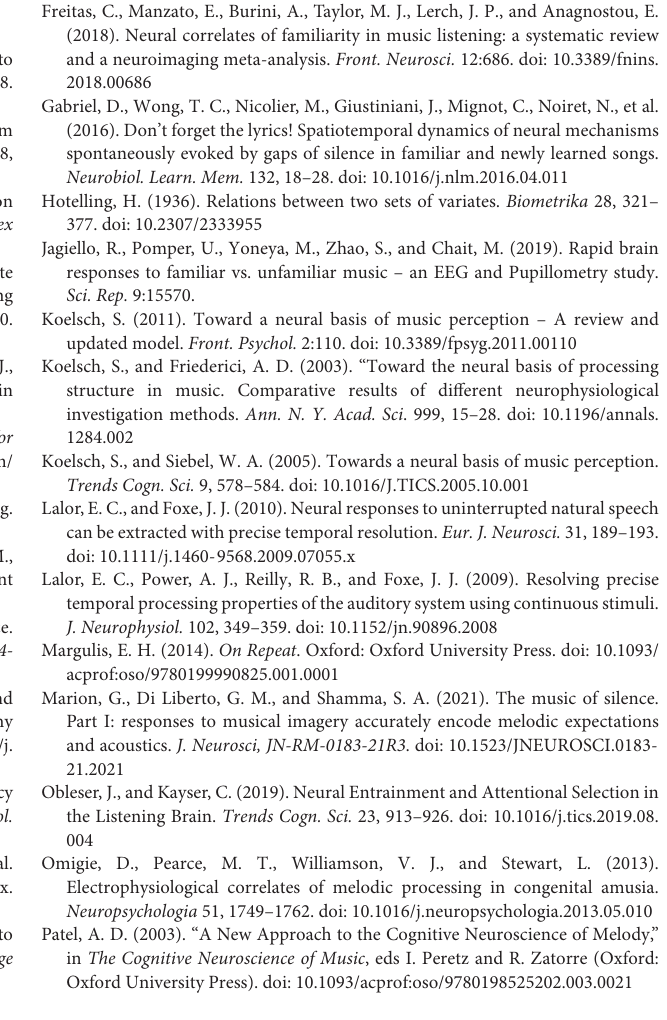
of decoding method (note-onset metric: p = 0.03; pitch metric: p = 4.2 × 10 − 4 ; post hoc Tukey’s HSD; * p < 0.05, ** p < 0.01, *** p < 0.001). Grey lines indicate the pitch decoding correlation scores with the maxCorr method when pitch information was shuffled among segments with identical timing. Scores larger than this baseline indicate that the decoding is partially driven by pitch-related EEG information. Bottom panels indicate the effect size (Cohen’s d) of the comparison between maxCorr and bTRFenv (blue dotted lines) and between maxCorr and the maxCorr baseline after shuffling the pitch values (grey solid lines). Supplementary Figure 2 | Single-subject Melody Decoding (1–30 Hz EEG). Single-subject melody decoding from EEG (1–30 Hz) with maxCorr. Note-onset decoding accuracies (left) and pitch decoding correlations (right) are reported for the imagery and listening conditions. Grey shaded areas indicate the chance level (95th percentile of a distribution obtained by shuffling 100 times the identification indices of the EEG segments for each subject). Supplementary Figure 3 | Linear decoding models (bTRF env ) fail to capture low-frequency EEG ( < 1 Hz) melody information in the listening condition. Melody decoding scores obtained with bTRF env are compared for EEG filtered in the bands 0.1–30 Hz and 1–30 Hz. The inclusion of the low frequencies between 0.1 and 1 Hz largely increases the decoding scores in the imagery and listening conditions (three-way repeated measures ANOVA, main effect of frequency-band; Note-onset: p = 0.09; pitch: p = 4.4 × 10 − 3 , post hoc Tukey’s HSD; * p < 0.05, ** p < 0.01, *** p <